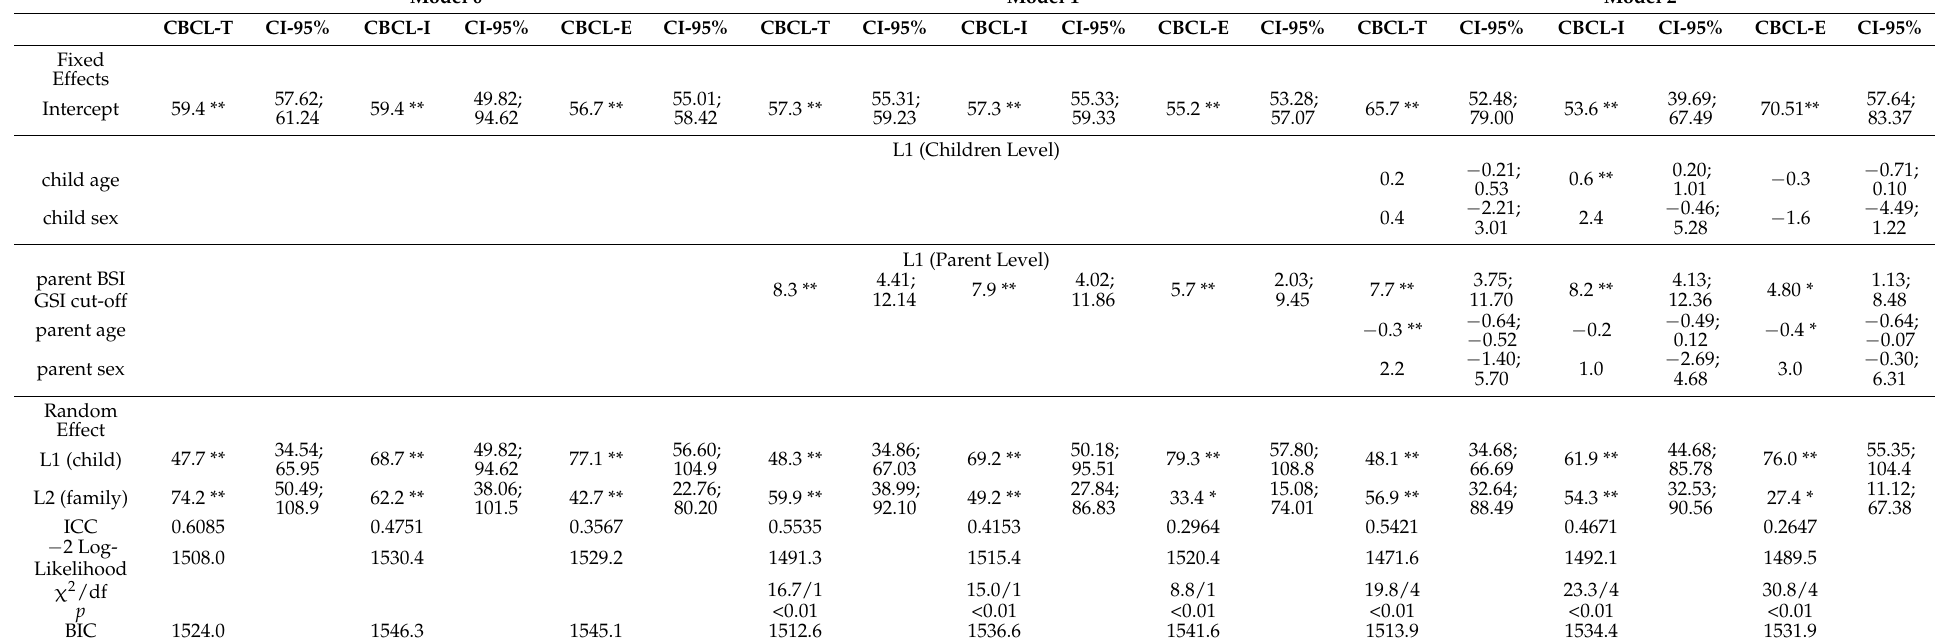
Table 6. BSI GSI cut-off (mentally ill parent) as a predictor for CBCL (children’s psychiatric symptoms). Model